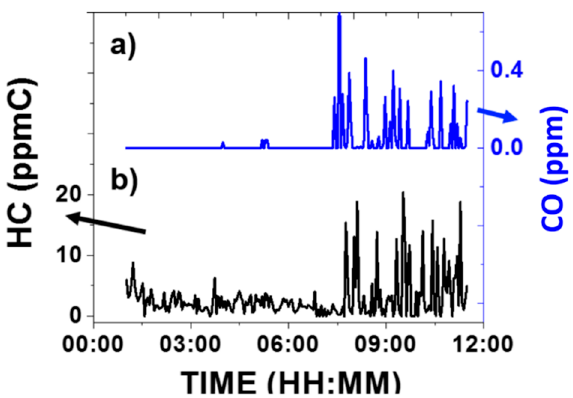
Figure 6. Outdoor testing of traffic markers as a function of time: ( a ) Concentration of Carbon Monoxide; ( b ) Corresponding concentration of total hydrocarbon (HC).